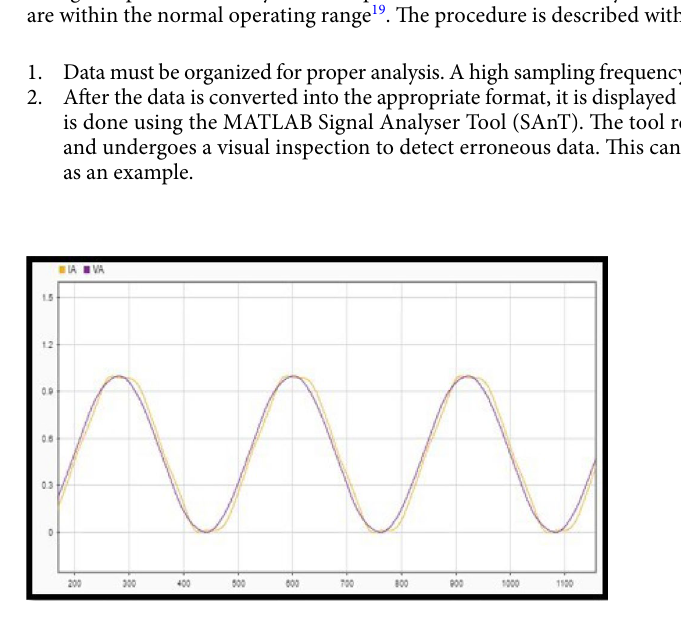
Figure 2. Superposition of voltage and current signals at the Policentro